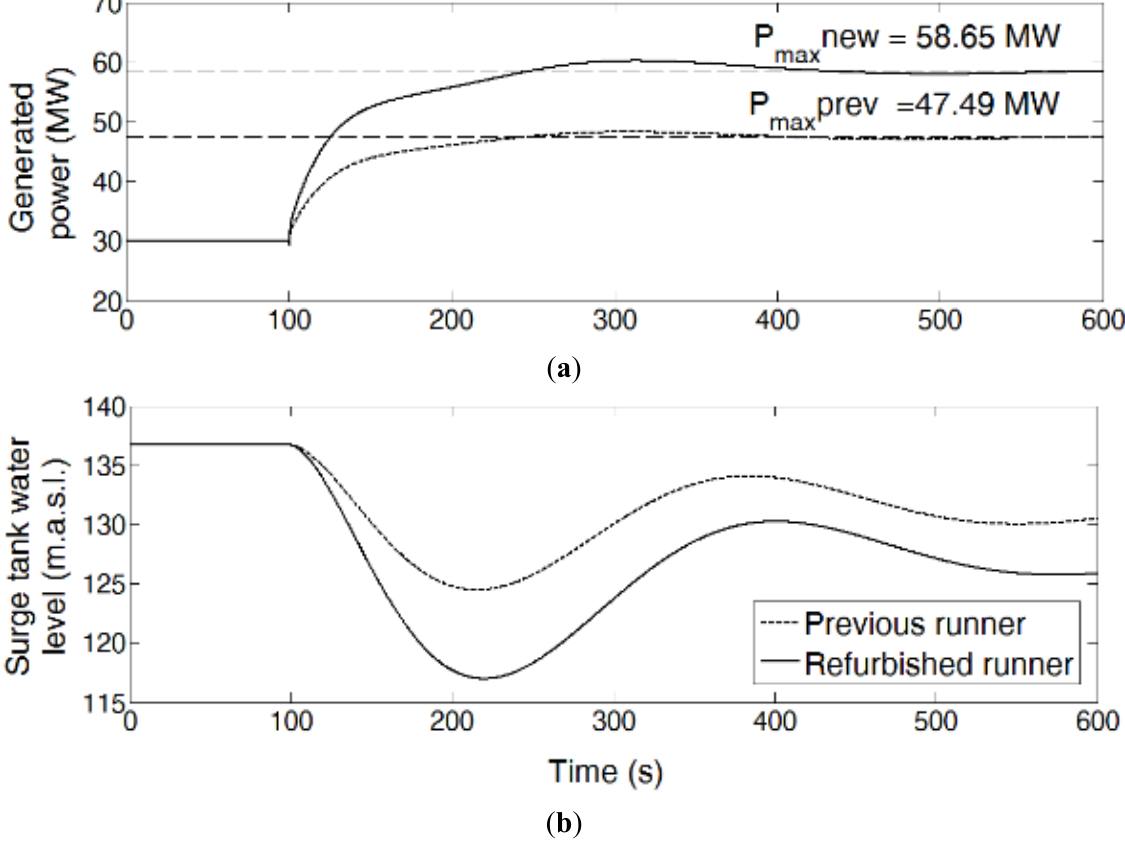
Figure 7. Evolution of ( a ) output power and ( b ) surge tank water level, with the old and new runner, in response to a ramp power set-point